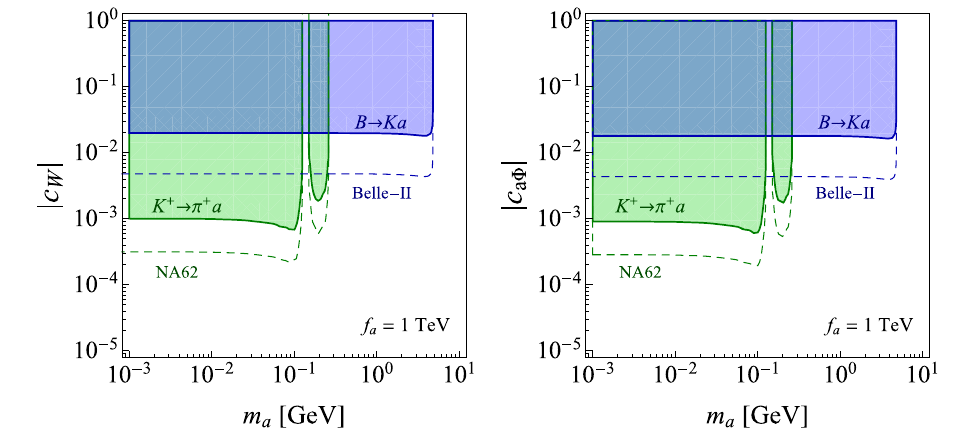
Fig. 2 Invisible ALP: constraints on the absolute value of c W (left panel) and c a (cid:7) (right panel) as a function of the ALP mass, consid- ering each of these couplings separately. The exclusion contours have been derived from the experimental limits on B ( K + → π + + inv ) [62]